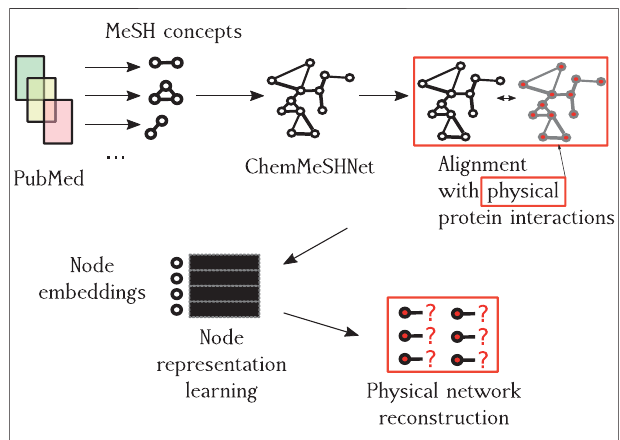
FIGURE1| Overviewoftheproposedapproach.The fi rstcontributionis the CHEMMESHNET , a network of term co-occurrences. Once constructed, the network is aligned with the space of empirically validated protein interactions (red squares), where the subset of proteins present in the annotations (nodes) of CHEMMESHNET are embedded into a low-dimensional space (node embeddings),andusedtolearnwhichlinksareactuallypresentandwhichare not. Oncetrained, thebest-performingclassi fi erpredicted scoresforpotential new interactions, which we also discuss as a part of qualitative evaluation.